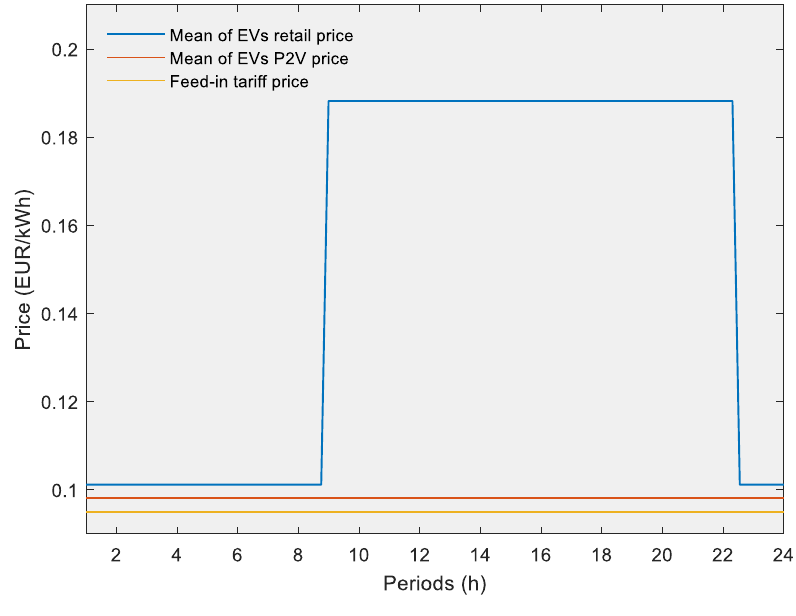
Figure 8. EV buy electricity prices.